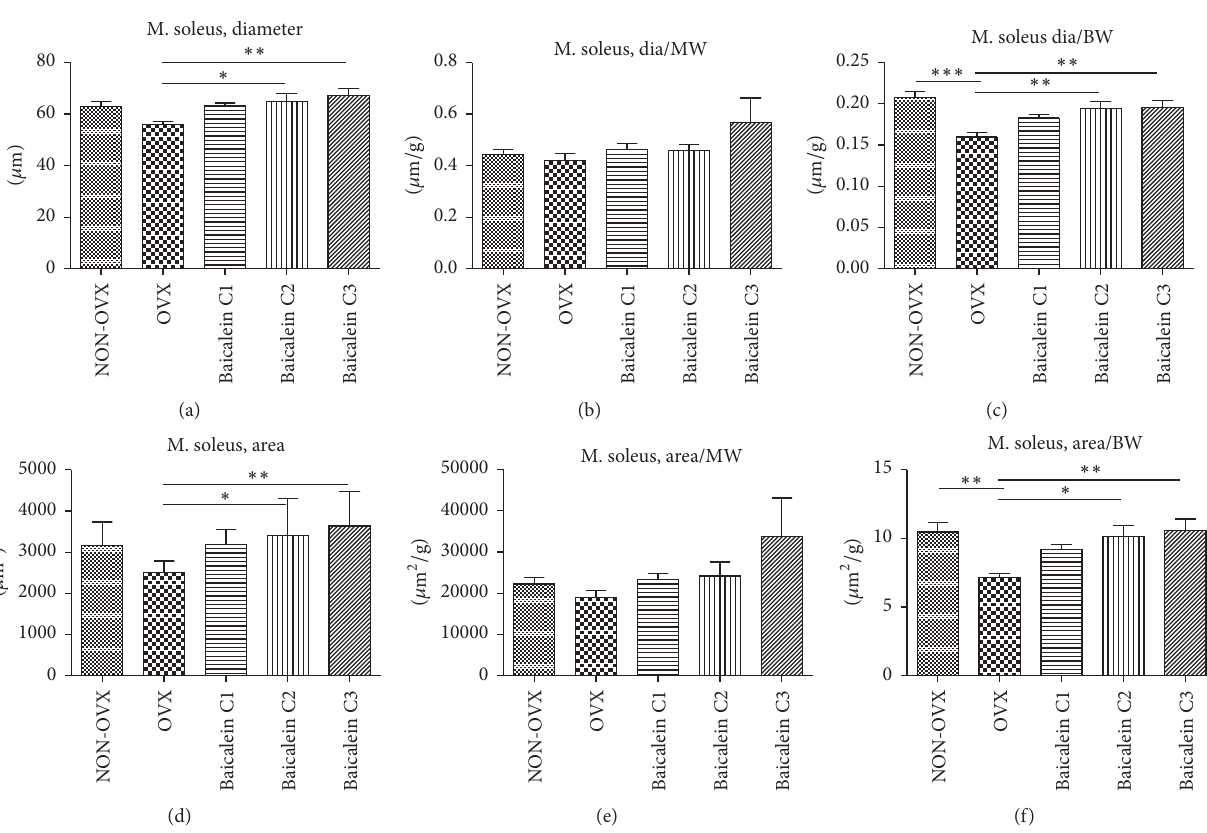
Figure 4: M. soleus fibre diameter and area and their relation to body weight. The diameter of single fibres was increased in each baicalein C2 and baicalein C3 group versus the OVX group ((a), 𝑛 = 46 ), while OVX does not differ significantly from C1 or NON-OVX. Muscle fibre areas were measured after preparing muscle sections. Although the area in the OVX groups was decreased when compared with that in NON-OVX animals, baicalein treatment could prevent this effect ((d), 𝑛 = 46 ). As for the relation of diameter to muscle weight, no significant differences could be seen ((b), 𝑛 = 41 ). Compared to body weight, the fibre diameters in NON-OVX rats were significantly greater when compared with those in OVX rats. Besides, fibre to body weight ratio was higher in the baicalein C2 and C3 animals versus OVX animals ((c), 𝑛 = 46 ). NON-OVX versus OVX animals had no differences in area/muscle weight ratio ((e), 𝑛 = 40 ) but a significantly greater area to body weight ratio; the same was noted for each baicalein C2 and baicalein C3 group versus the OVX group ((f), 𝑛 = 46 ). ∗ 𝑝 < 0.05 , ∗∗ 𝑝 < 0.01 , and ∗∗∗ 𝑝 < 0.001 indicate significant